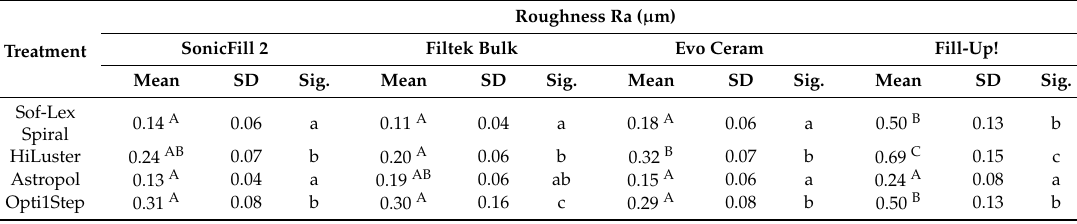
Table 3. Descriptive statistics of surface roughness (Ra, µ m). Lowercase letters label statistically significant di ff erences among finishing systems within each restorative material. Upper case letters label the statistically significant di ff erences among the four materials within each treatment ( p < 0.05).